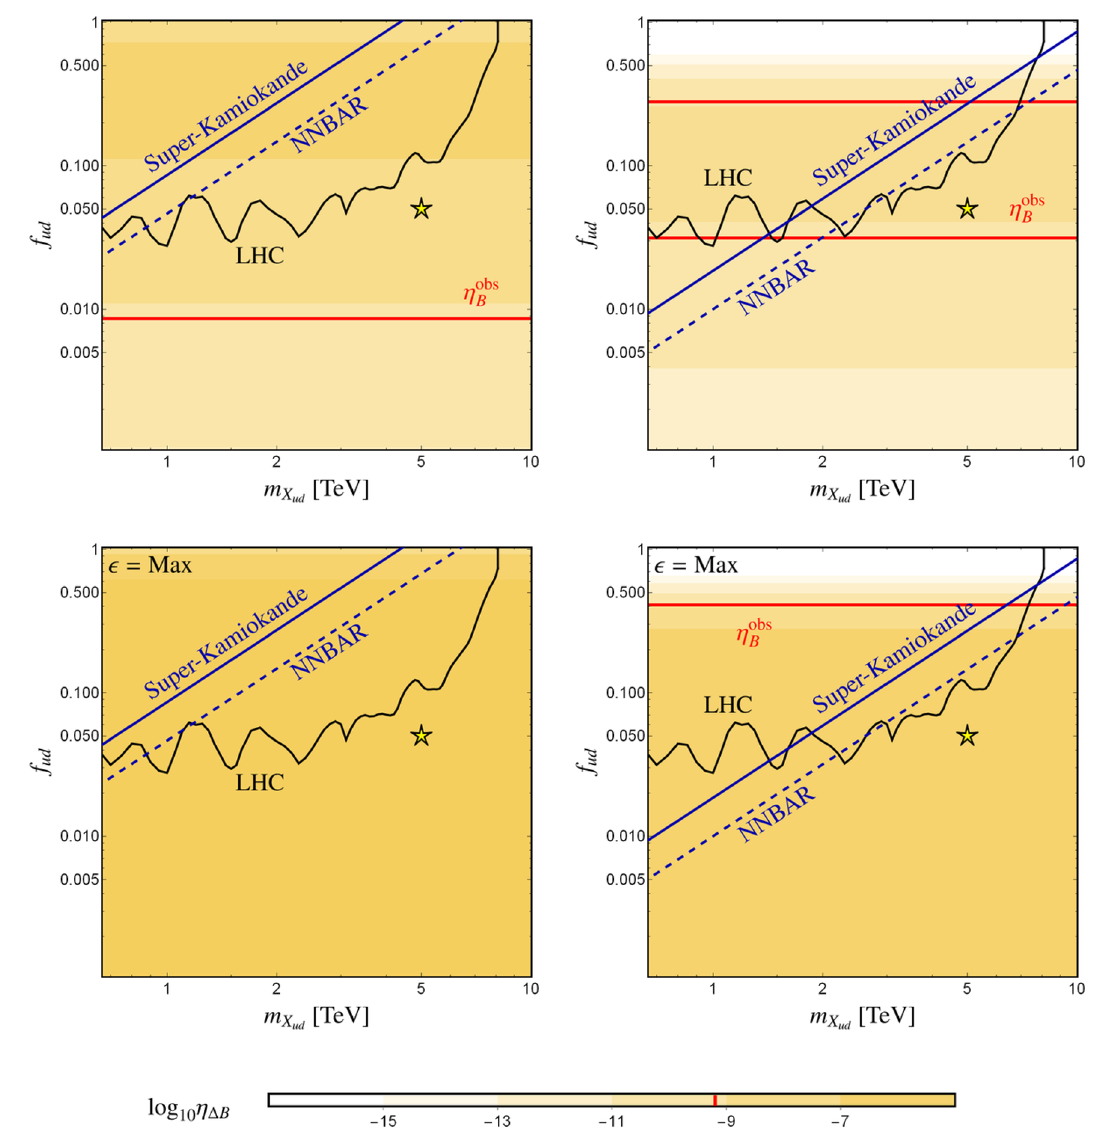
Figure 17 . High-scale scenario. Yellow shading indicates the number density of baryon num- ber η (normalised to photon number density) at the time of electroweak symmetry breaking in ∆ B the m – f plane under the assumption of f = f and λv 0 = 1 . 5 m . Top row: the CP- X ud ud ud dd X dd violating parameter (cid:15) (as defined in eq. (5.1) ) is chosen with x = 0 . 2 . Bottom row: the maximum value (cid:15) = 2 r is used. Left column: m = 10 14 GeV. Right column: m = 10 13 GeV. The red line X dd X dd marks the observed value for the baryon asymmetry η obs = 6 . 2 × 10 − 10 , the blue lines correspond B to exclusion limits from n - ¯ n oscillation set by Super Kamiokande (solid) and future exclusion limits set by NNBAR (dashed). The black lines correspond to the exclusion limit from dijet production √ at the LHC based on CMS-searches with s = 13 TeV and 36 fb − 1 integrated